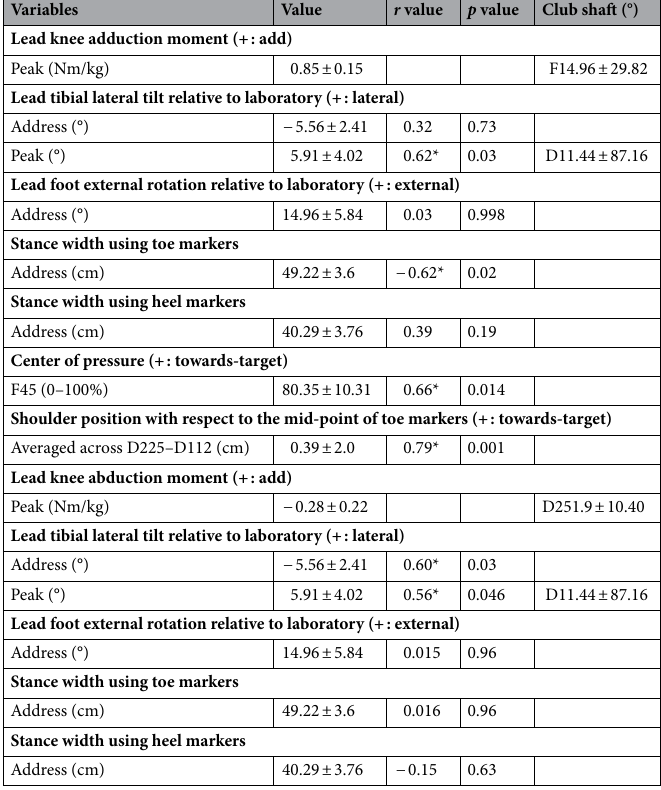
Table 1. Spearman correlations between the peak knee adduction and abduction moments of the lead leg and lead tibial lateral tilt at address and its peak, lead foot external rotation at address (performed Pearson correlation), and stance width at address using toe and heel markers. In addition, Spearman correlations between the peak knee adduction moment of the lead leg and center of pressure position at F45 and shoulder position during the downswing (D225–D112). F: follow-through, D: downswing. (mean ± SD). *significant at p <